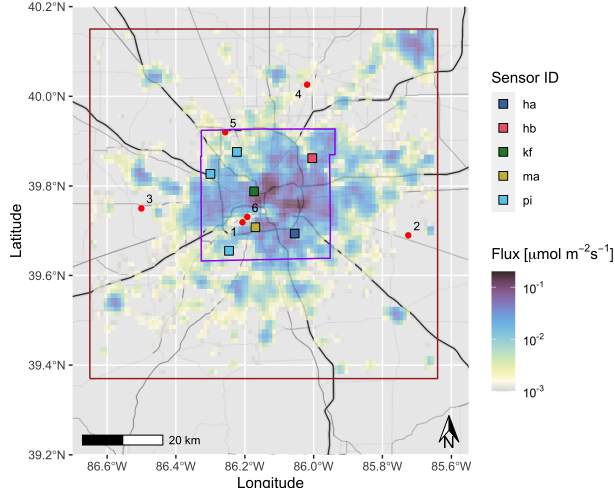
Figure 1. Prior estimate of emissions due to natural gas infrastruc- ture. EM27/SUN deployment locations are shown with squares. Lo- cations of known point sources are also shown (red circles, sum- marized in Table 1). The study domain is shown in brown, and the boundary of Marion County is shown in purple. Map tiles